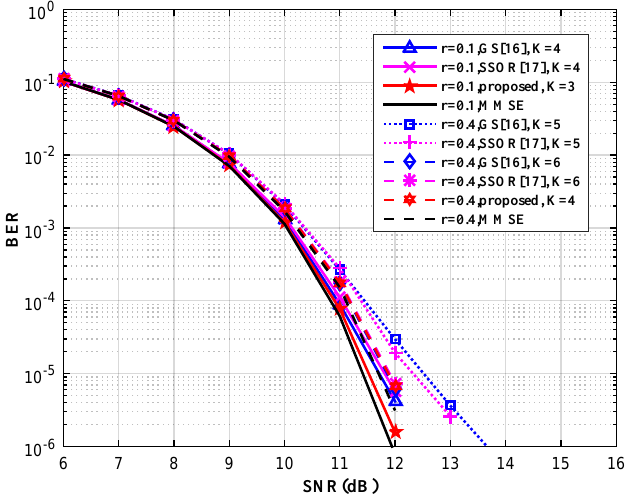
Figure 7. BER curves with different values of correlated